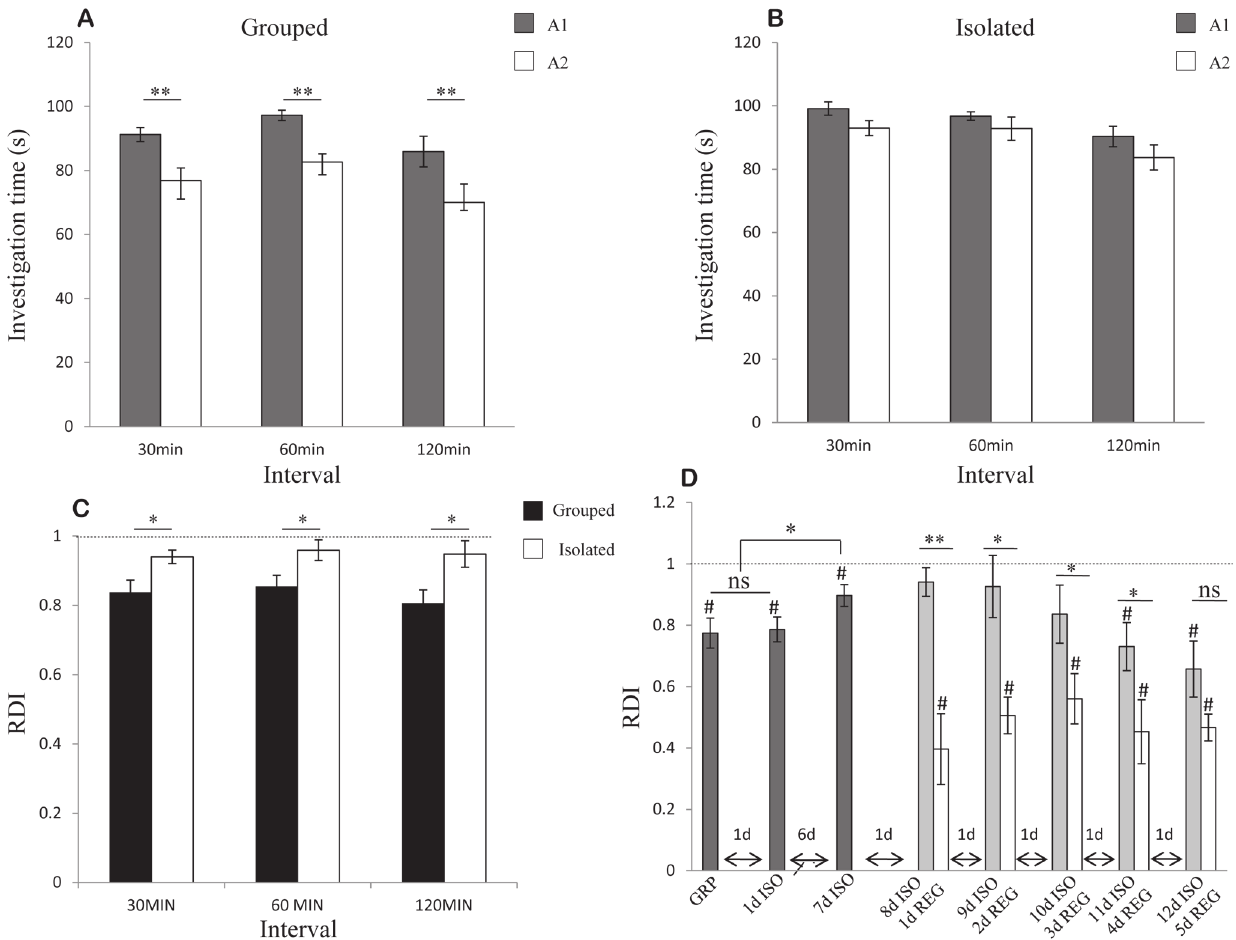
Figure 4. Short-term SRM was also impaired by social isolation (mean ± SEM). A) Rats in group housing displayed a significant decrease in SIT during the second 2 min encounter with a juvenile (A2, empty bars) compared to the first (A1, gray bars), regardless of whether the encounters were separated by 30, 60 or 120 min. Paired t-test: ** p , 0.01, n=10 for 30 and 120 min, n=9 for 60 min. B) Socially isolated rats did not display a significant decrease in SIT during the second 2 min encounter regardless of the interval between the encounters. Paired t-test: p . 0.05, n=10 for 30 and 60 min, n=12 for 120 min. C) Socially isolated rats (empty bars) showed a significantly higher RDI than animals from group housing (black bars) at all three time intervals. Paired t-test: * p , 0.05, Grouped: n=10 for and 120 min, n=9 for 60 min. Isolated: n=10 for 30 and 60 min, n=12 for 120 min. D) RDI values for two 2 min encounters with the same juvenile 30 min apart. This test was repeated with the same group of adult males (n=20) while housing conditions were changed, using new stimuli for every session. Short-term SRM was confirmed for every session if a significant reduction in SIT between the first and second encounters was found using paired t-test ( # p , 0.05). Dark grey bars represent RDI values of 20 adult male rats in group housing (GRP) as well as after 1 day (1 d ISO) and 7 days (7 d ISO) of social isolation. Note that, unlike long-term SRM (Fig. 3A), there was no significant increase in RDI compared to animals from group housing (GRP) after 1 day of social isolation. These animals were then divided into two groups: one group remained in social isolation (ISO, light-grey bars) and the other was returned to group housing (REG, empty bars). Both groups performed the same test on a daily basis. A profound difference between the two groups appeared even 1 day following division (t-test * p , 0.05, ** p , 0.01), but was gradually reduced. On the last day of the experiment animals in both groups showed short-term SRM, with no significant difference between them. GRP, paired t-test: t (19) = 4.89, p , 0.01). The animals were then placed in solitary cages and examined a day later (1 d ISO) using the same test, with no significant change observed in SRM acquisition (t (19) =5.41, p , 0.01). However, when the same animals were examined after seven days in social isolation (7 d ISO), there